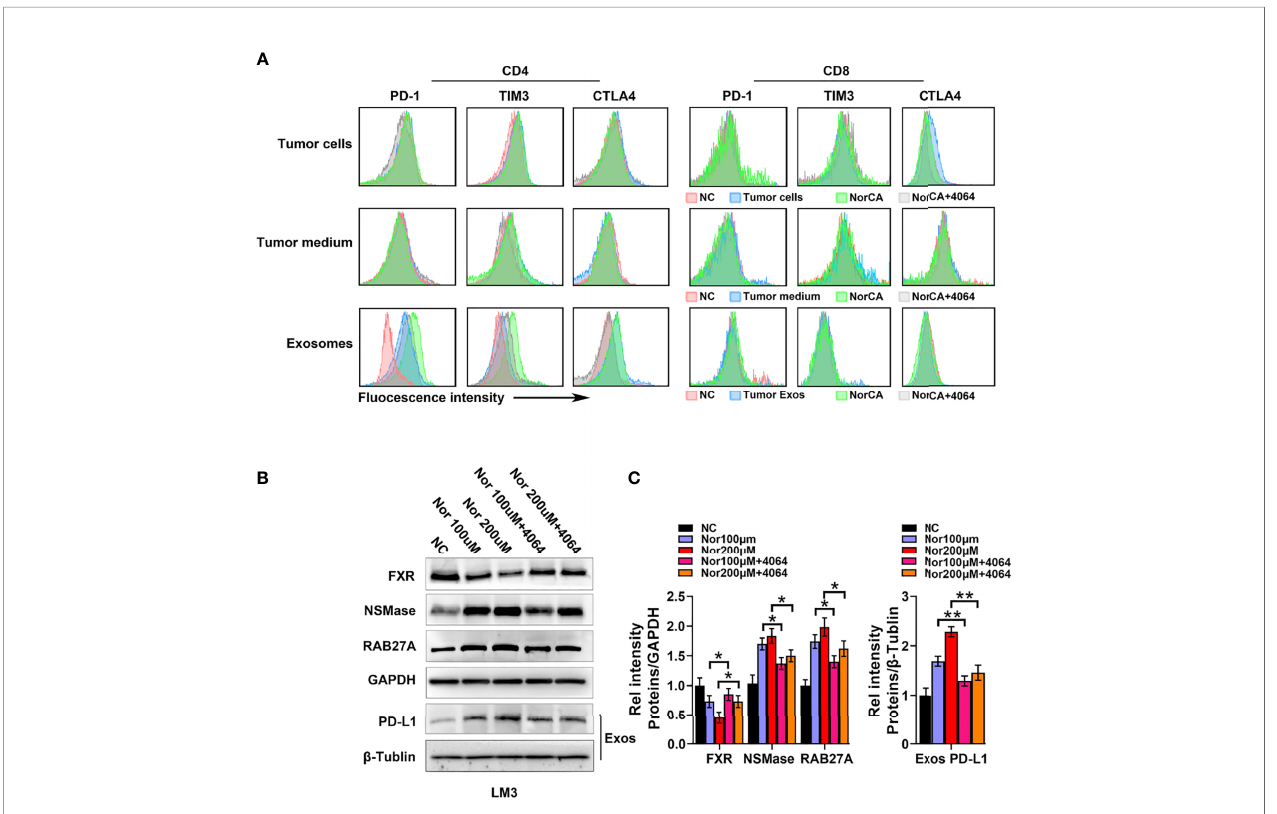
FIGURE 4 | NorCA mediates the immune microenvironment by promoting tumor-derived Exos secretion. (A) After cells were exposed to NorCA, fl ow cytometry was applied to analyze the change in immune checkpoint-speci fi c markers (PD-1, CTLA-4, and TIM3) in CD4 + T cells and CD8 + T cells cocultured with tumor cells, medium from tumor cell or tumor-derived Exos. Tumor-derived Exos regulated CD4 + T cells, as evidenced by the signi fi cantly higher expression of PD-1 and TIM3. (B) The FXR, NSMase, and RAB27A levels in tumor cells and PD-L1 levels in the tumor-derived Exos were detected using western blot analysis. (C) gray value analysis of all proteins. *p < 0.05 and **p <